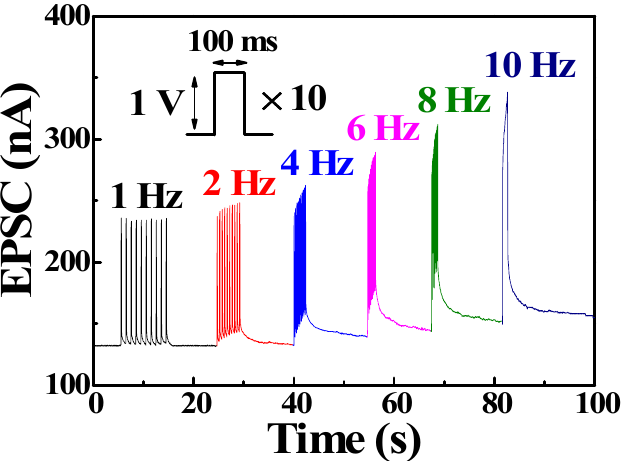
Figure 6. Dynamic filter behavior recorded in response to 10 cycles of spikes at different frequencies (1 to 10 Hz).